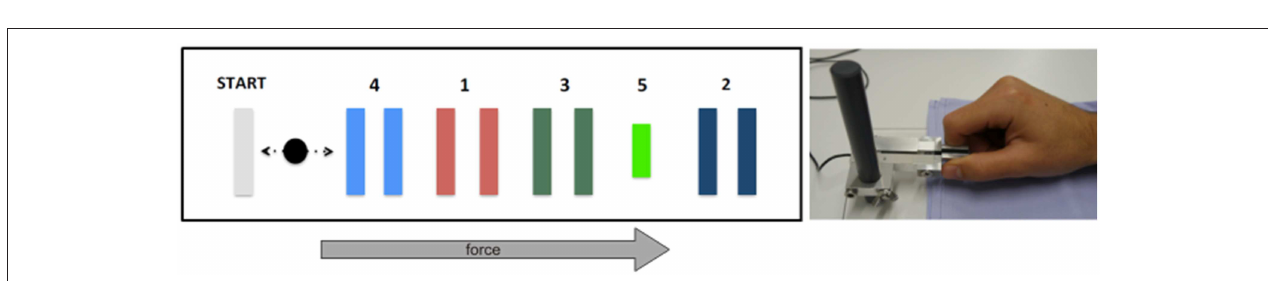
FIGURE 2 | Experimental overview of sequential visual isometric pinch task. Subjects were required to move the black cursor horizontally toward the numbered gates (left) by modulating pinch on a force transducer between thumb and index finger (right) . See main text for details.